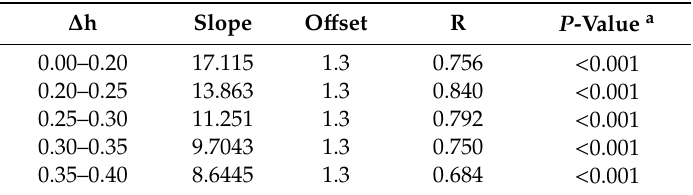
Table 2. The linear regression analysis of the relative height di ff erence ( ∆ h) of di ff erent segments with a Scale of 1.3. ∆ h Slope O ff set